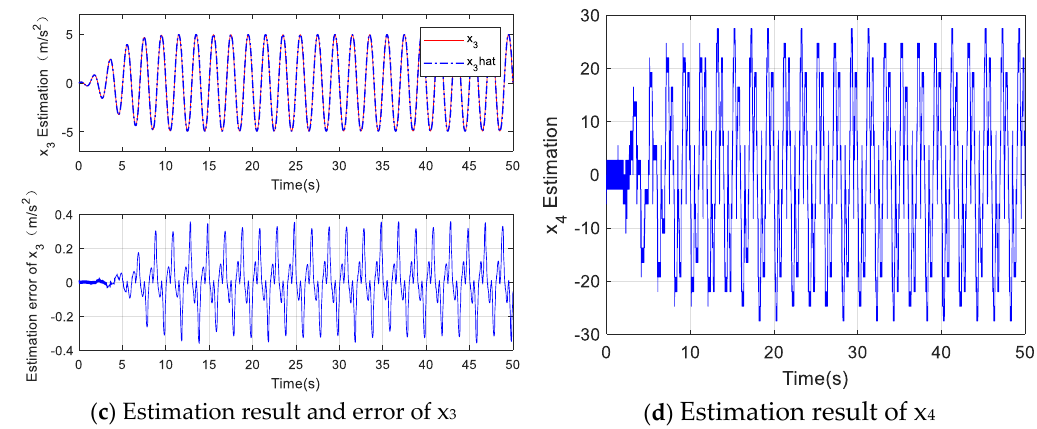
Figure 4. Estimation results of finite time observer.